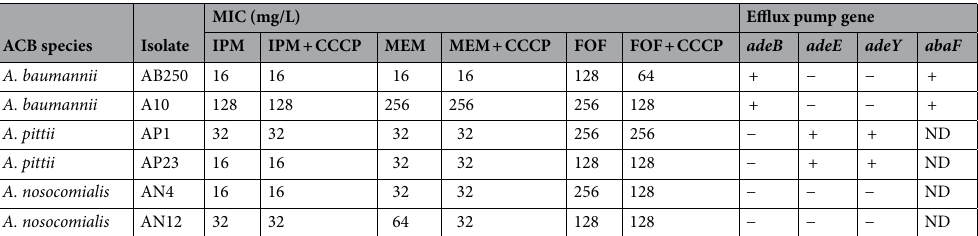
Table 2. MICs of imipenem (IPM), meropenem (MEM), and fosfomycin (FOF) in either with or without CCCP and the presence of efflux pump gene of six ACB isolates. The positive result for efflux overexpression was defined as the decreased MICs at least fourfold at the presence of CCCP. The presence of efflux pump genes was determined by PCR. (+) presence of gene, (−) absence of gene, ND not determined.